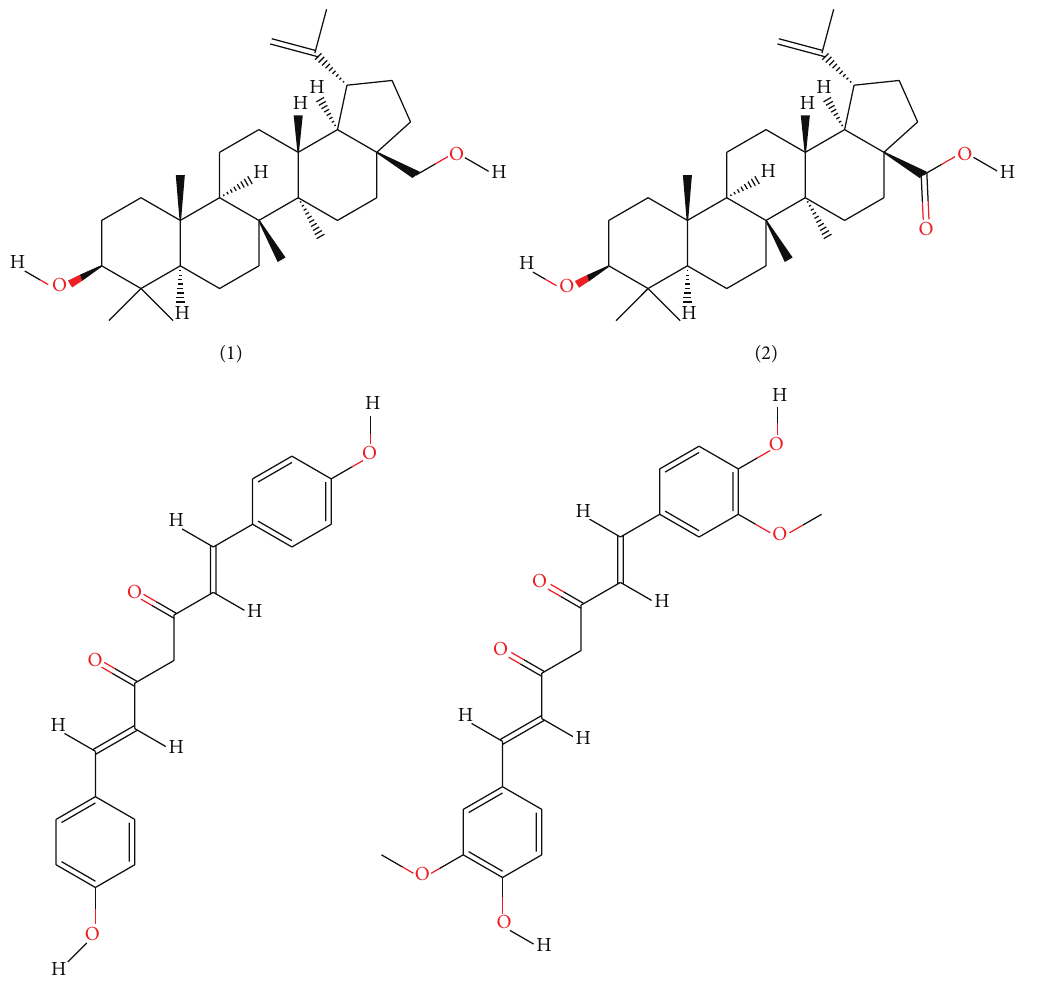
Bisdemethoxycurcumin and Curcumin failed to follow